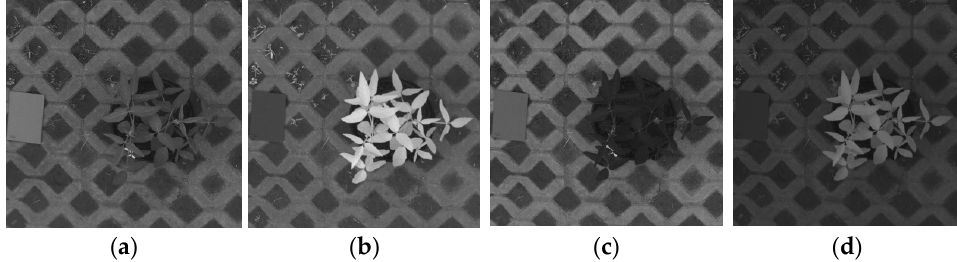
Figure 2. Original multispectral image of the soybean canopy: ( a ) GRE original image, ( b ) NIR original image, ( c ) RED original image, and ( d ) REG original image.